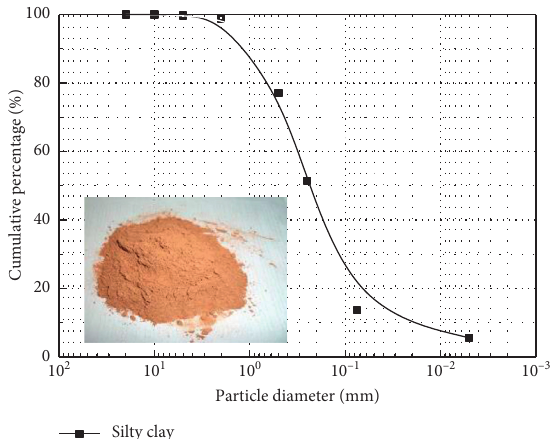
Figure 6: Flexible boundary loading device.